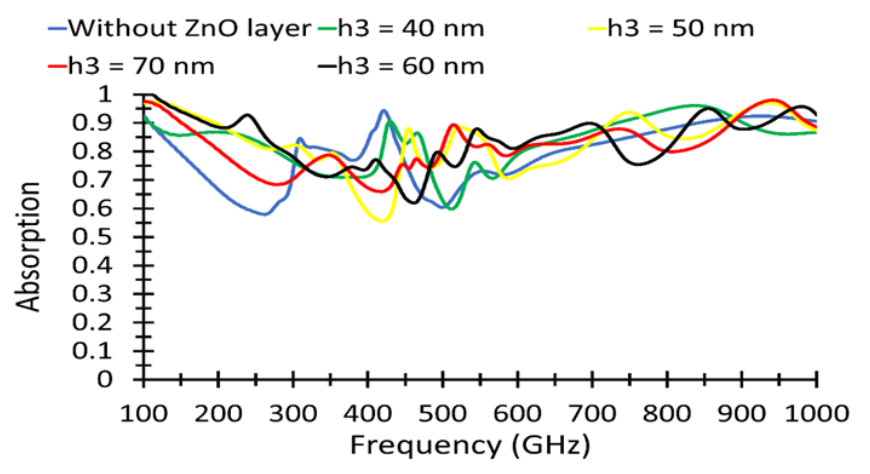
Figure 10. Effect of adding ZnO layer with different thicknesses, 40–70 nm, on the absorption of the absorber. Table 3. Absorption for different dielectric substrates.